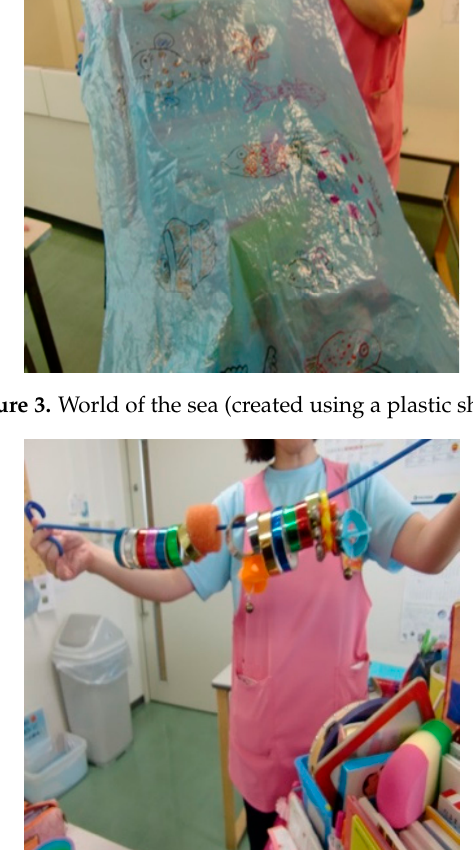
Figure 4. Cord and rings.